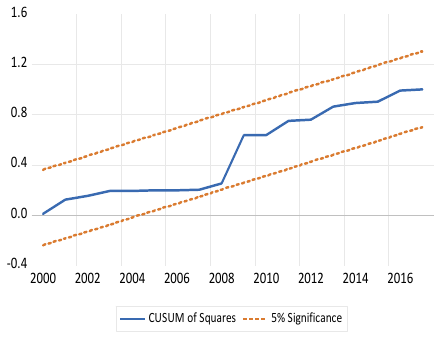
Figure 3. COSUMQ test for the linear ARDL model.